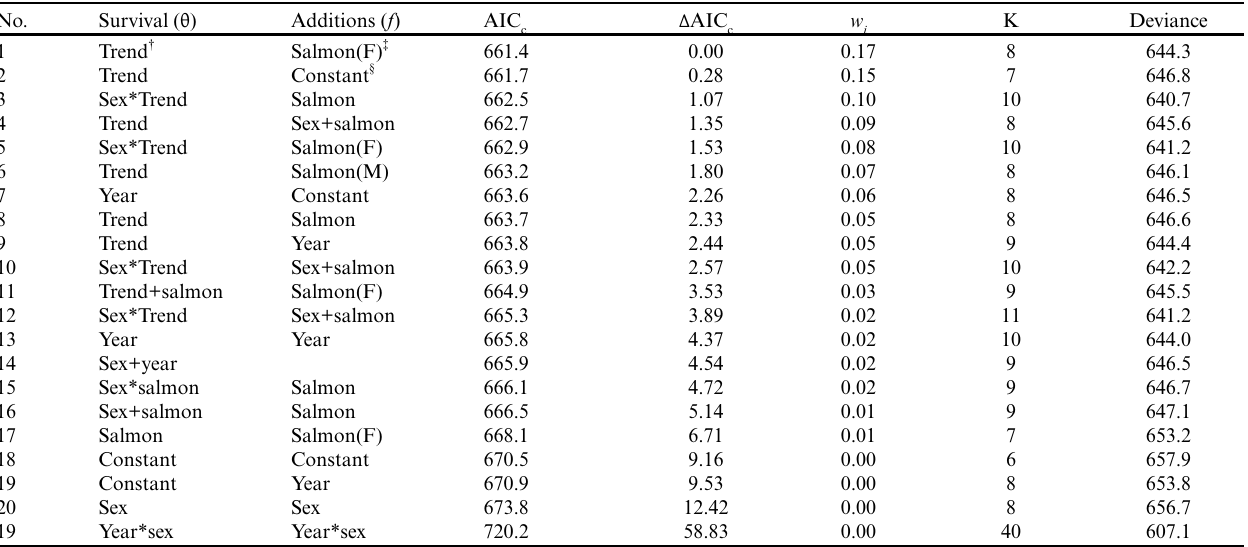
Table 3 . Pradel model selection results for the Koeye grizzy bear ( Ursus arctos horribilis ) DNA mark-recapture analysis 2006-2009. A model with yearly detection probabilities was used for all models. Akaike Information Criteria (AIC between the ith model and the model with the lowest AIC deviance are